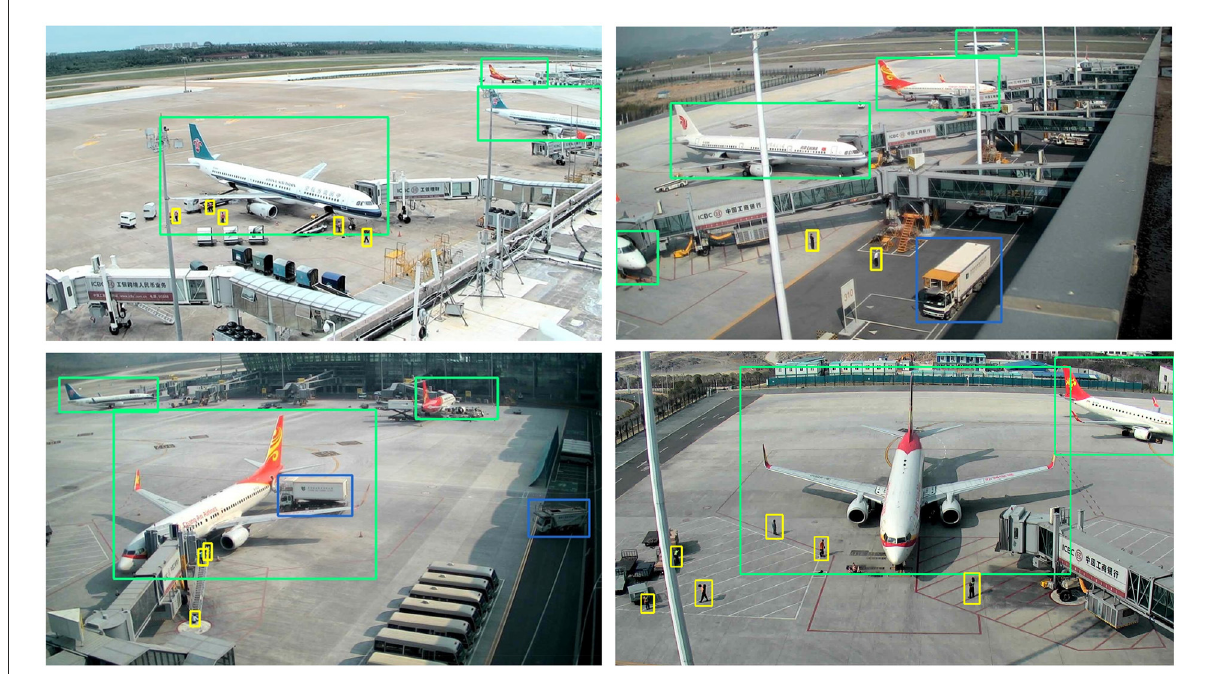
FIGURE5 Several examples of detection results on the airport dataset. We can see that the objects with very small size such as pedestrians have been clearly detected by our proposed model.